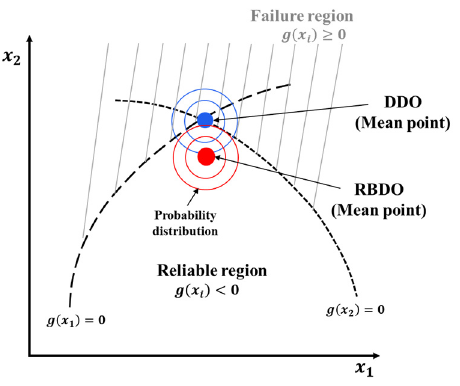
Figure 4. Schematic comparison between the reliability-based design optimization (RBDO) and deterministic design optimization (DDO).